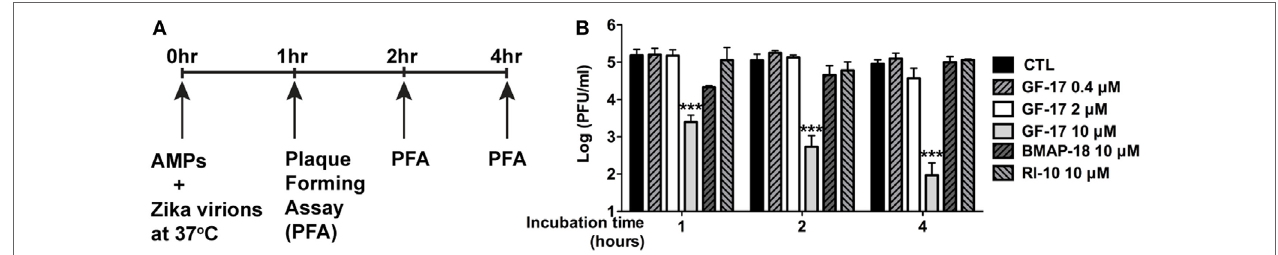
FigUre 7 | GF-17 directly inactivates Zika virions. (a) Experimental scheme. Briefly, Zika virus (ZIKV) virions were directly treated with antimicrobial peptides at 37°C. Part of the inoculum was removed at the indicated time points and serial diluted for the plaque-forming assay to determine the number of infectious Zika virions. (B) Quantification of the viral plaques was performed and plaque-forming unit at each of the treatment groups was shown. ANOVA and Bonferroni post-test were performed on all groups. *** p < 0.001, as compared with the ZIKV control group (CTL,